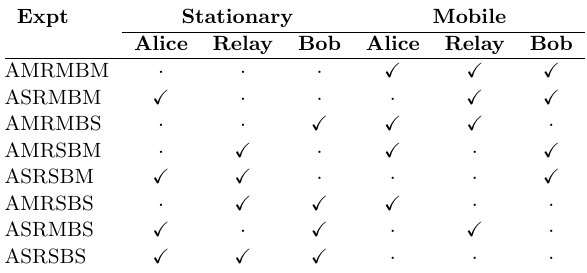
vices Alice, Bob and Relay were worn on the right arm of 3 different subjects and for stationary scenarios, the